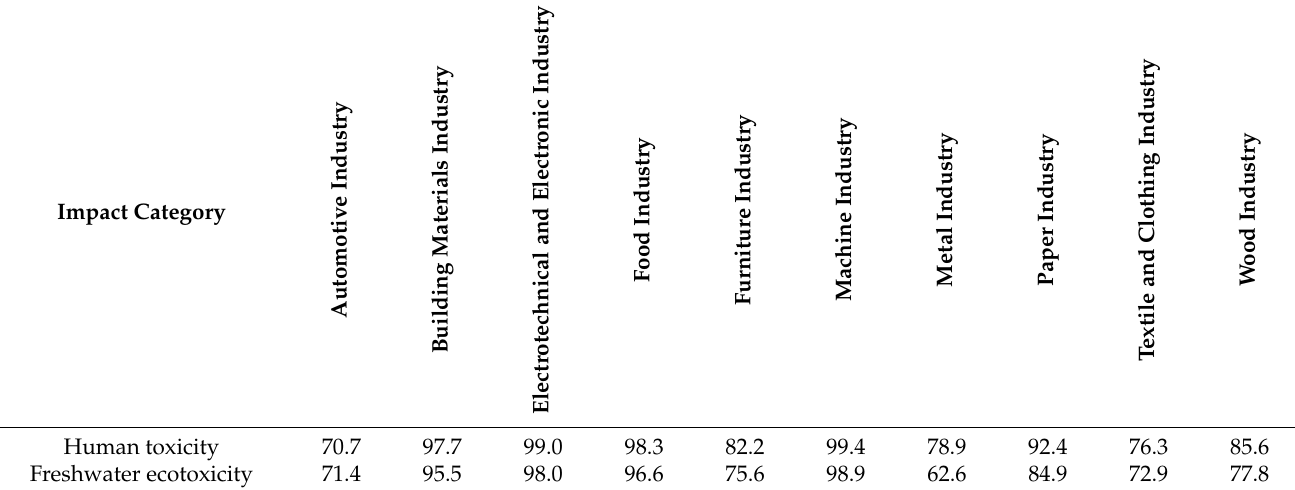
Table 3. Percentage potential reductions in environmental impacts.